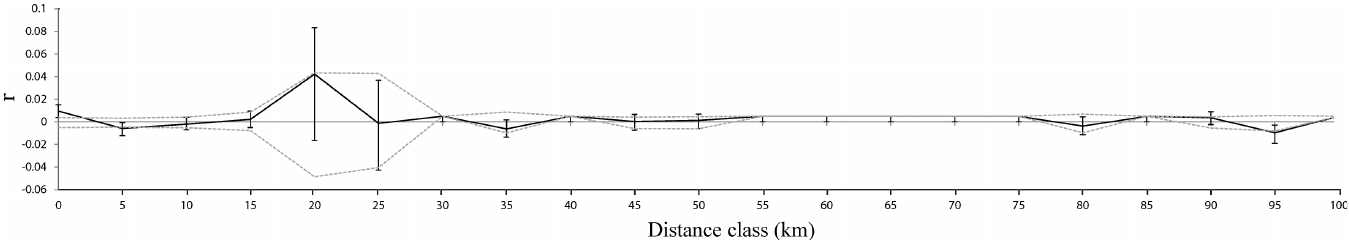
Fig 4. Spatial autocorrelation analysis. Based on 204 Alticus arnoldorum samples for microsatellite data excluding putative null alleles. Autocorrelation r values (black line) are presented in relation to the 95% confidence belt (dotted lines). Error bars at each distance class represent the confidence interval around the observed value of r based on 999 bootstrap permutations of the data. The probability values for a one-tailed test for positive autocorrelation, together with upper and lower bounds for the confidence intervals and bootstrap re-sampling are in S5